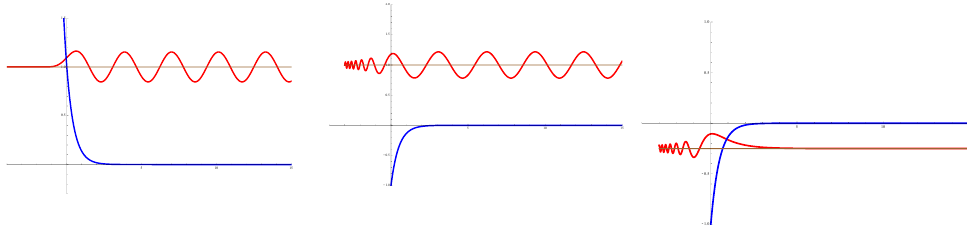
Figure 9 . Blue: Liouville potential V ( φ ) . Red: wavefunction solution with energy eigenvalue marked by the brown line. Left: νλ > 0 for k = 1 with energy value k 2 = 1 . Middle: νλ < 0 for k = 1 with energy value k 2 = 1 . Right: νλ < 0 for j = 0 with energy value k 2 = − 1 / 4 .